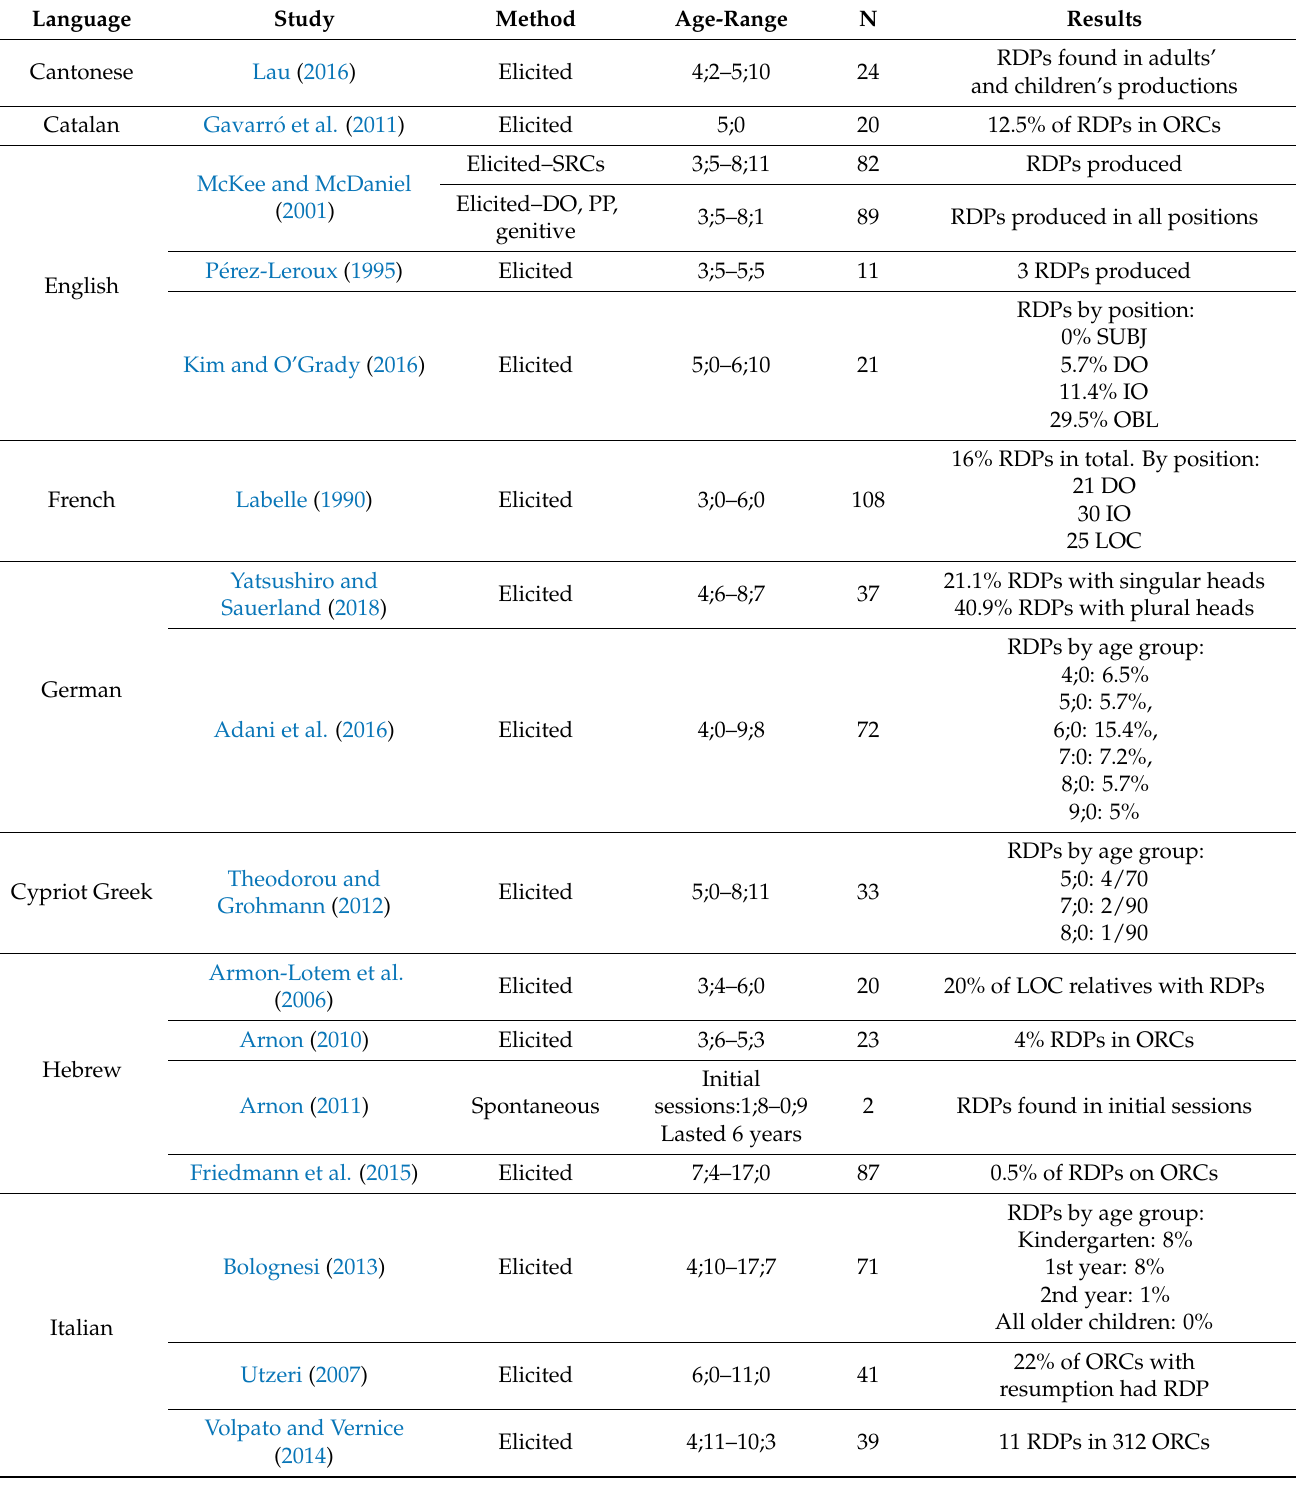
Table A3. Data on resumptive DPs